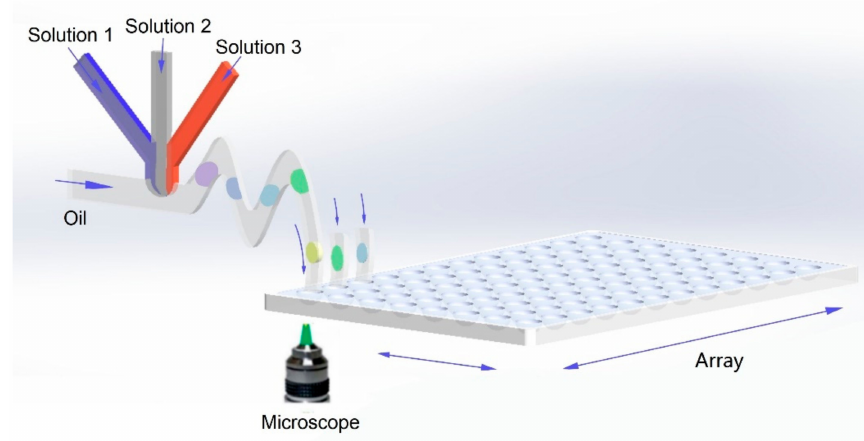
Figure 5. A demonstration of high-throughput-screening platform that combine droplet generator, microarray and high-throughput characterization for screening material